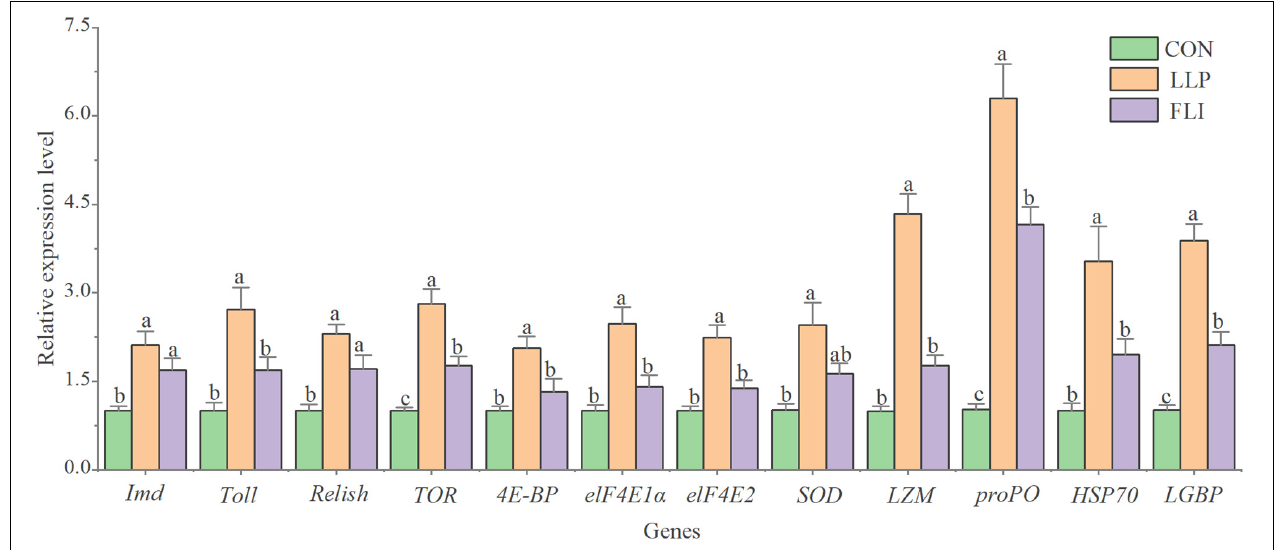
FIGURE 7 | Expression levels of hepatopancreatic immune-related genes of P. vannamei.